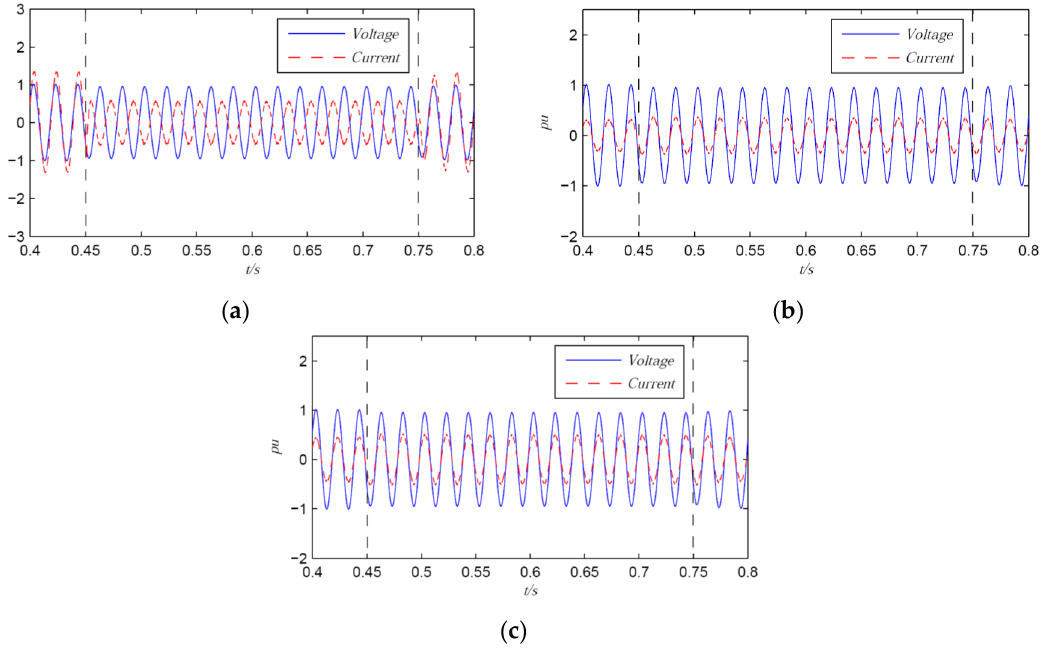
Figure 21. Single-phase voltage and current curves of micro-source. ( a ) Voltage and current output of storage battery; ( b ) Voltage and current output of PV; ( c ) Voltage and current output of wind turbine.